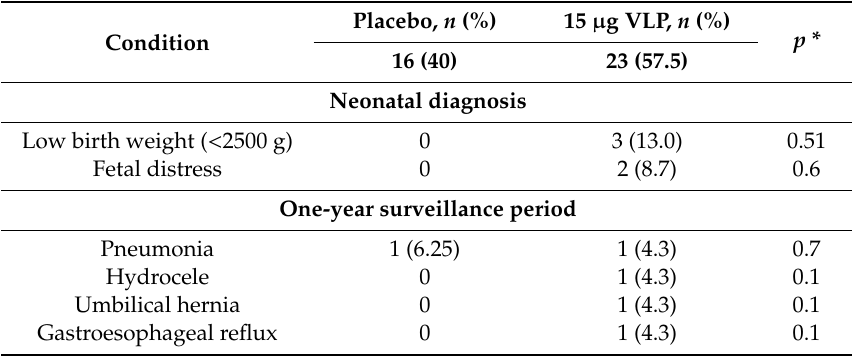
Table 4. Neonatal and one-year surveillance adverse events in infants of women in the vaccinated and placebo